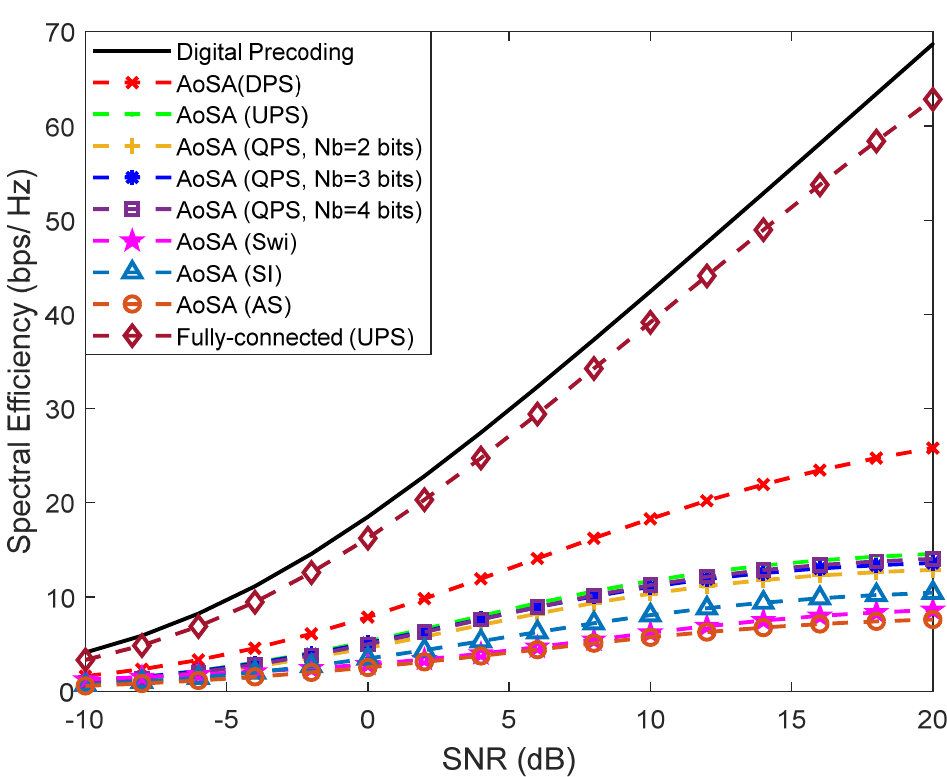
Figure 8. Spectral efficiency versus SNR achieved by the proposed precoder using different AoSA architectures with L max = 1, N u = 4, N s = 2, N tx (with LOS component).